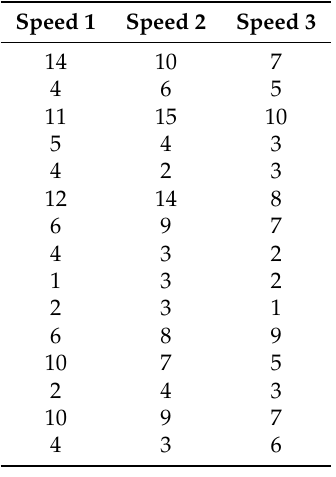
Table A2. Processing time of operations of the small instance.